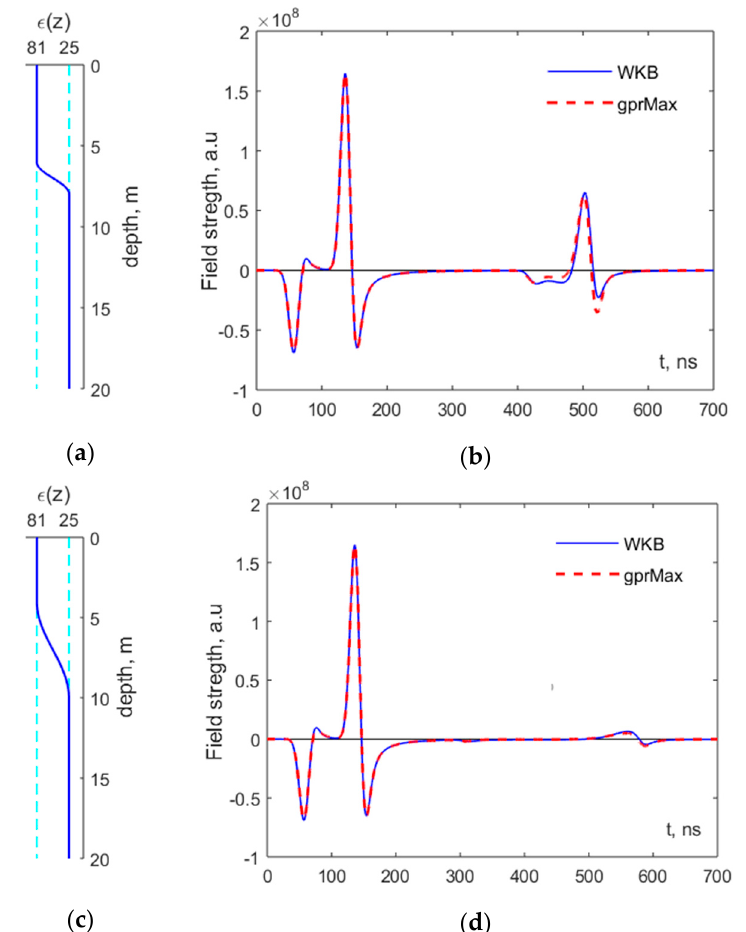
Figure 5. Two vertical profiles of the dielectric permittivity are shown in ( a , c ). The corresponding simulated A-scans (coupled WKB: solid line, gprMax: dashed line) are shown in ( b , d ), respectively.